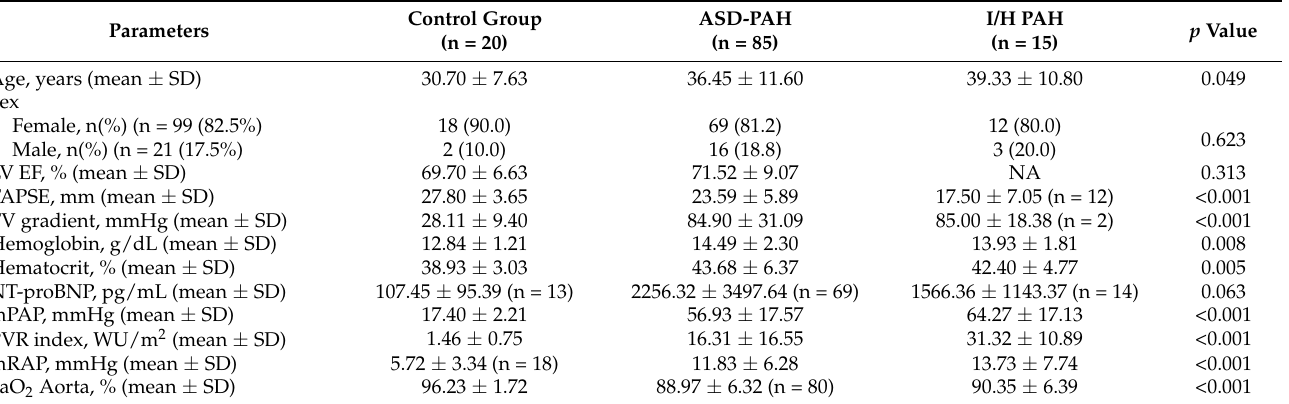
Table 1. Characteristics of subjects—patients with ASD without PH as the control group, ASD-PAH patients and I/H PAH patients.